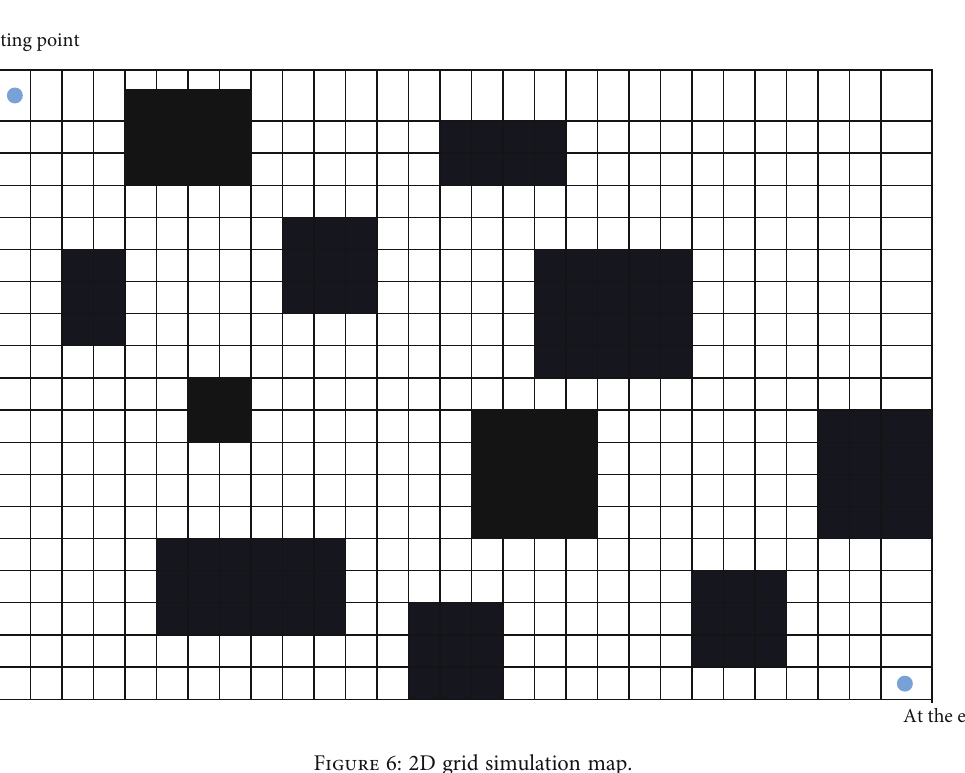
Figure 6: 2D grid simulation map.